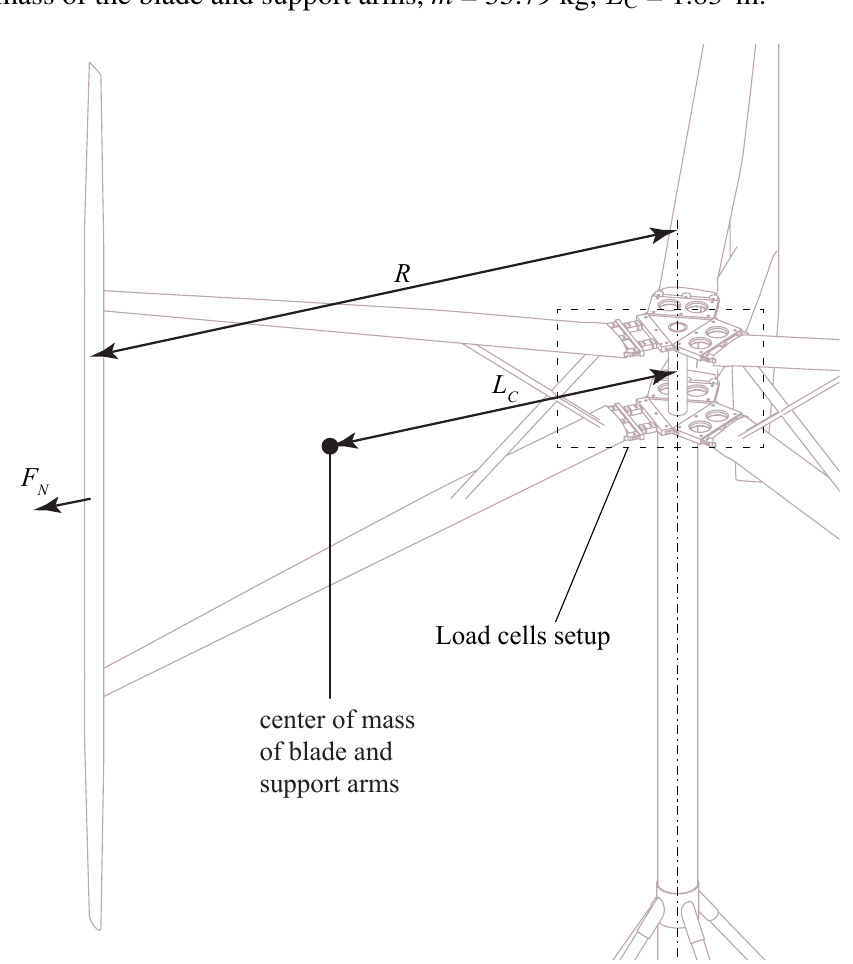
Figure 3. The turbine blade with installed load cells and the notation of the normal force F